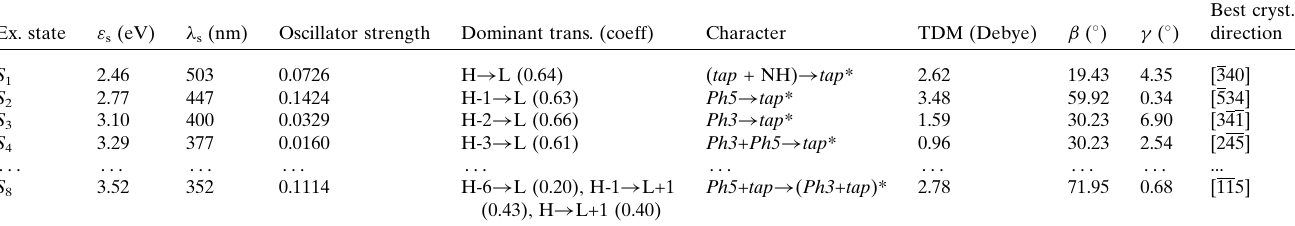
Table 1 Low-lying optical transitions (singlets only) of the TAAP monomer in the gas phase, calculated at the TD-DFT/B3LYP level. The transition wavelengths ( (cid:5) s ) are obtained after shifting the TD-DFT transition energies by (cid:7) 0.33 eV ( " s ). H is the highest occupied molecular orbital (HOMO) and L is the lowest unoccupied molecular orbital (LUMO). (cid:6) is the angle between the direction of the permanent dipole moment (PDM) and the transition dipole moment